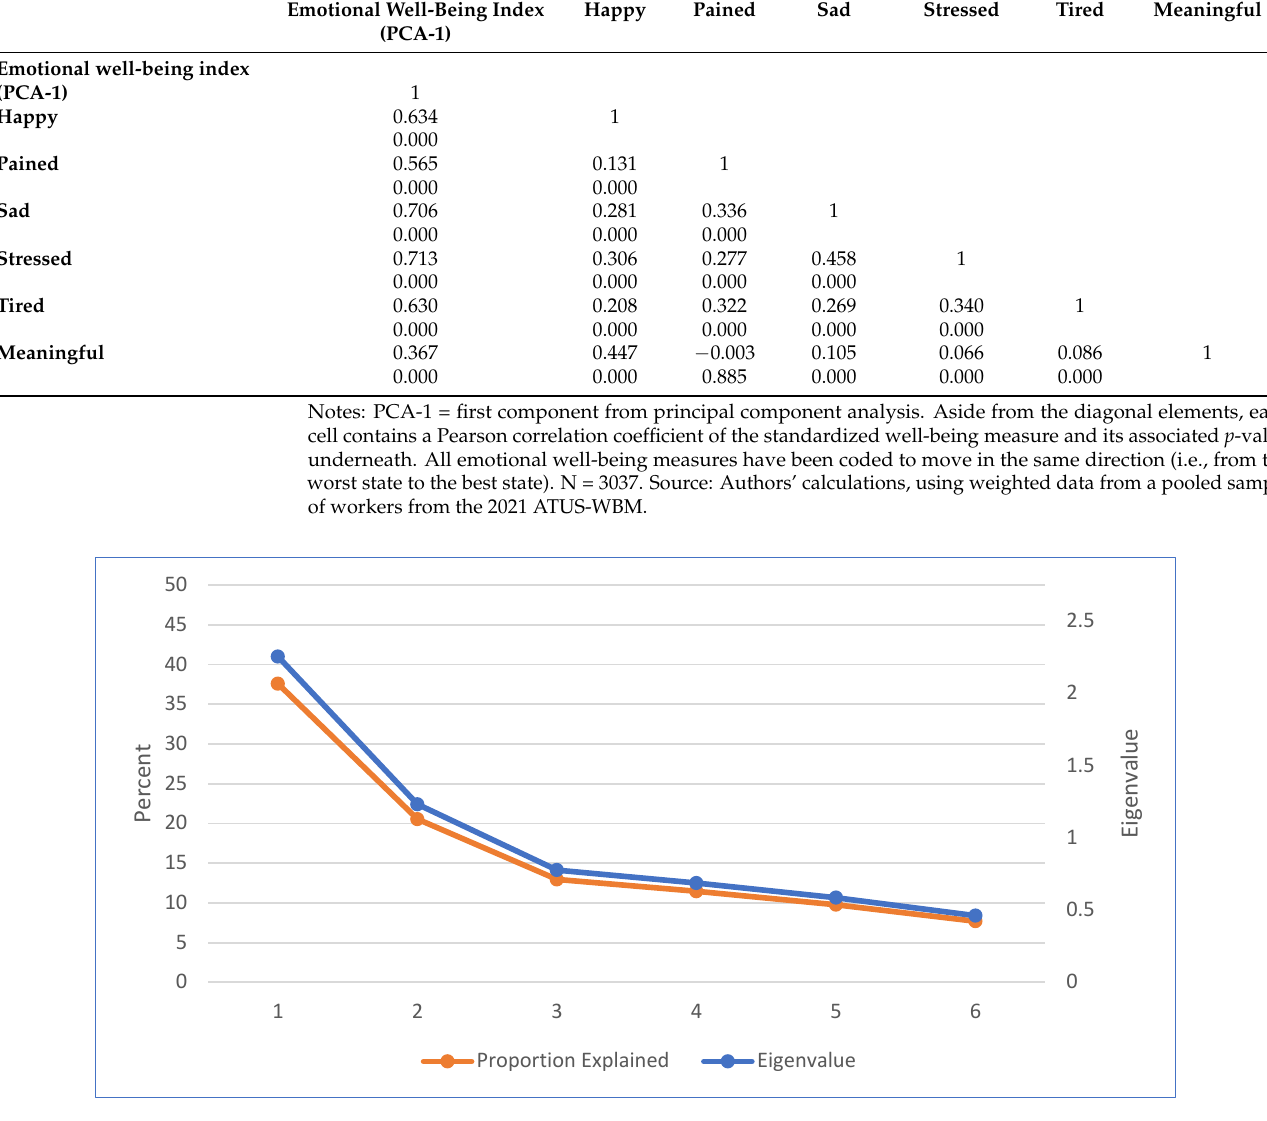
Figure A1. Percent of the total variance explained and eigenvalues from a principal component analysis using six well-being measures, by component. Notes: ATUS-WBM final activity sampling weights are used in this principal component analysis using six well-being measures (happy, tired, stressed, sad, and pained, as well as the meaning attached to each of those activities). N = 3037. For each component, the primary y-axis shows the percent of the total variance explained while the secondary y-axis shows the eigenvalue. Source: Authors’ calculations, using data from the BLS 2021 ATUS-WBM. Table A4. Matrix of Pearson correlation coefficients involving five well-being measures. Happy Pained